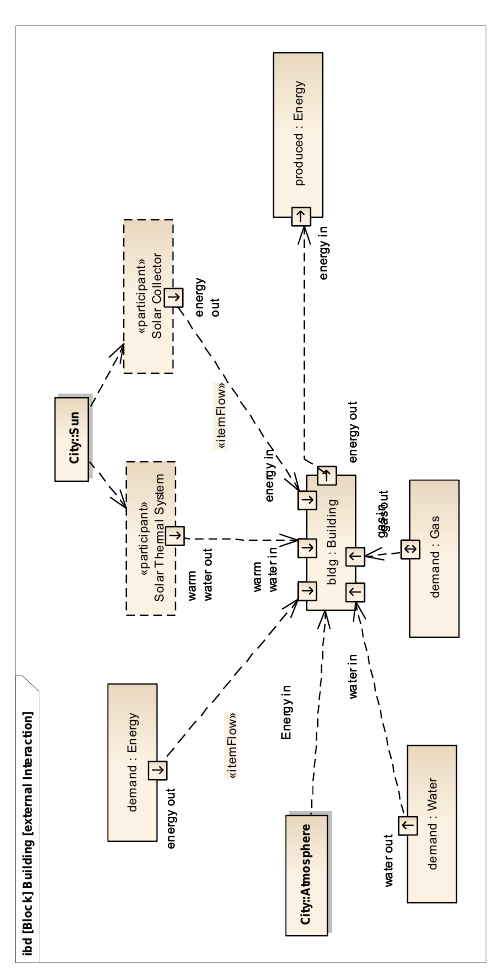
Figure 7. example (ibd) for external interaction of a building block with external